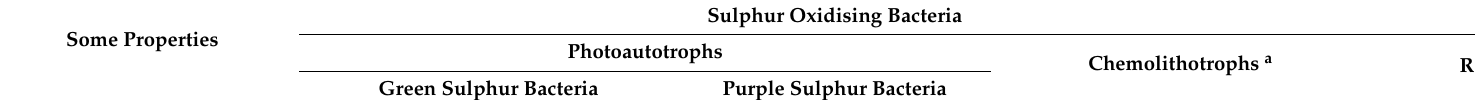
Table 2. Summary of some notable properties of sulphur oxidising bacteria considered in the present